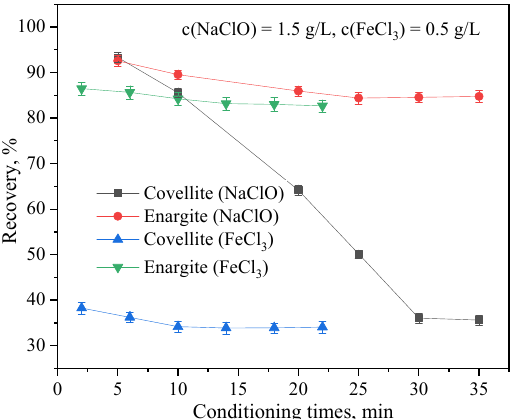
Figure 6. Effect of the depressant conditioning time on the flotation behavior of covellite and enargite at pH = 10.